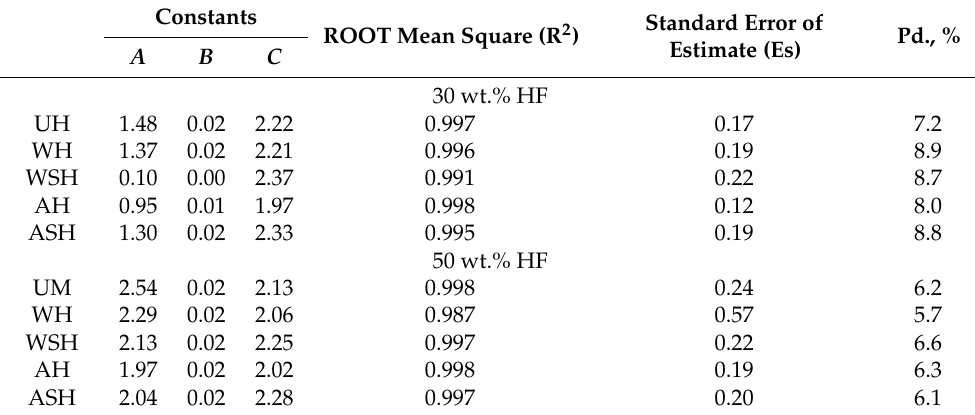
Table 5. Adsorption parameters and goodness of fit for Oswin model determined from sorption isotherms of untreated (UH), and treated (WH, WSH, AH and ASH) composites at 30 and 50 wt.% of hemp fiber content.